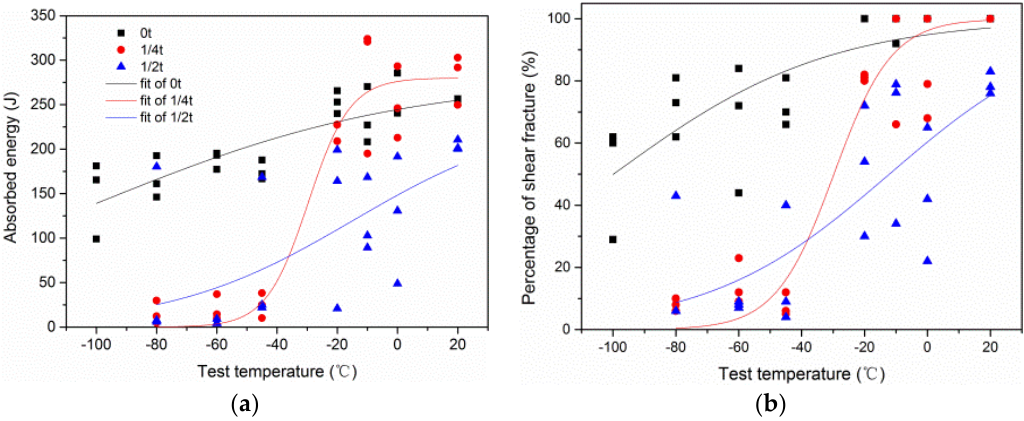
Figure 5. Ductile-brittle transition determined by Charpy impact tests of 130 mm-thick plates. ( a ) absorbed energy; ( b ) percentage of shear fracture.